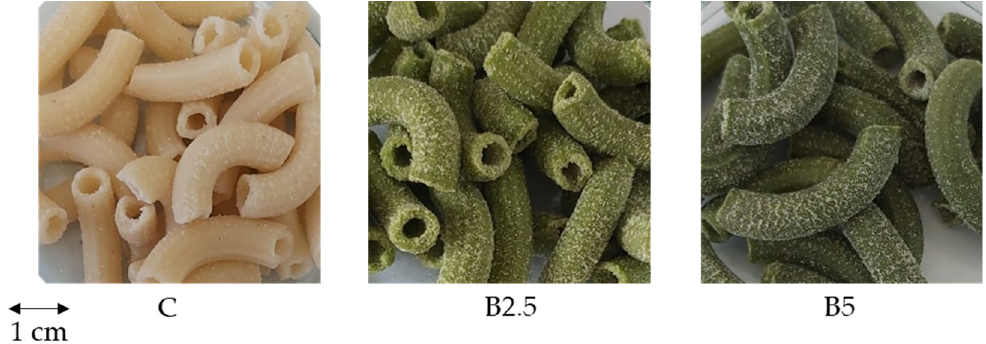
Figure 1. Experimental pasta fortified with BLP. C: control pasta; B2.5: pasta fortified with 2.5% broccoli leaf powder; B5: pasta fortified with 5% broccoli leaf powder.